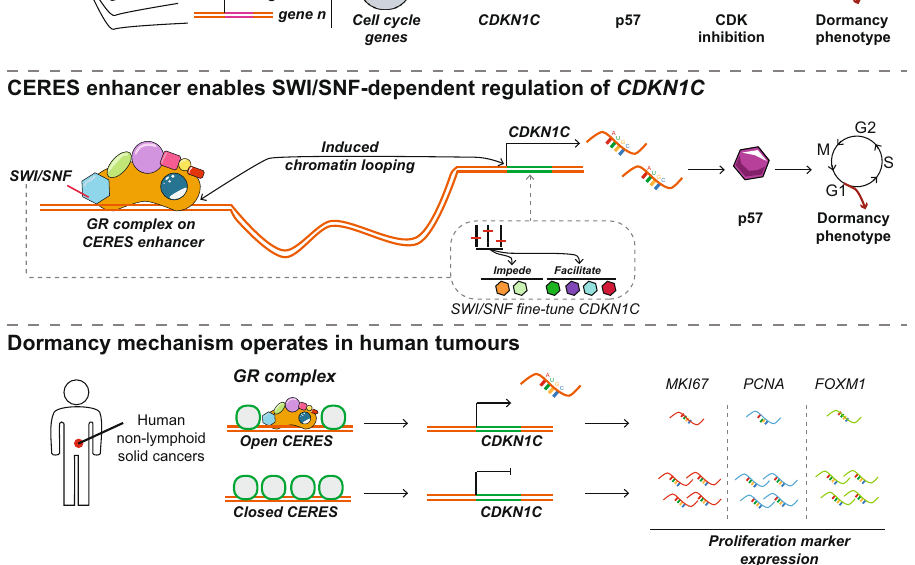
Fig. 7 Mechanism of GR-driven, reversible drug-tolerant cancer cell dormancy. Glucocorticoids act on lung cancer cells by evoking a reversible cell cycle arrest, activating senescence programs, attenuating the metabolic processes, reducing sensitivity to a large array of drugs, inducing dependency towards growth hormone signalling (IGF-1R) and initiating expression of CDKN1C . While GR regulates a large number of genes throughout the genome, we identi fi ed that the cell dormancy phenotype is driven by a single GR-target gene, CDKN1C , which encodes for p57, a potent CDK inhibitor protein. This GR target is necessary for the attainment of the cell dormancy phenotype. Regulation of CDKN1C involves a distal enhancer CERES (C DKN1C Enhancer Regulated by Steroids) located upstream of CDKN1C in the KCNQ1 gene, through a GR-induced chromatin looping event. GR and its transcription machinery initiate transcription from the CDKN1C locus, this in turn leads to the acquisition of a cell dormancy phenotype. Crucial for transcriptional activity of GR at CDKN1C locus is the SWI/SNF complex, as its members fi ne-tune GR transcriptional output allowing for precise control of gene expression. This mechanism of regulation is observed in non-lymphoid solid human cancers, where it contributes to tumour